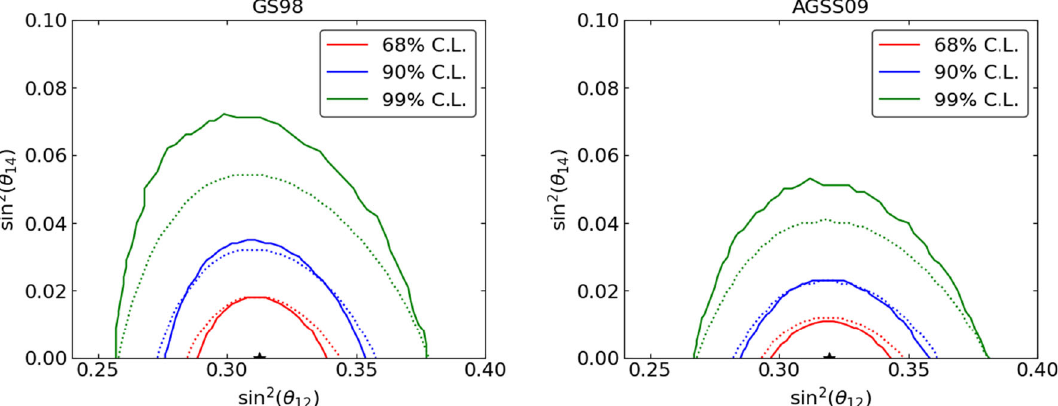
Fig. 3 Monte Carlo confidence regions at 68%, 90%, and 99% CL (solid) compared to (cid:4)χ 2 contours based on Wilks’ theorem using the χ 2 distribution with 2 dof (dotted). The left (right) panel is for the GS98 (AGSS09) solar